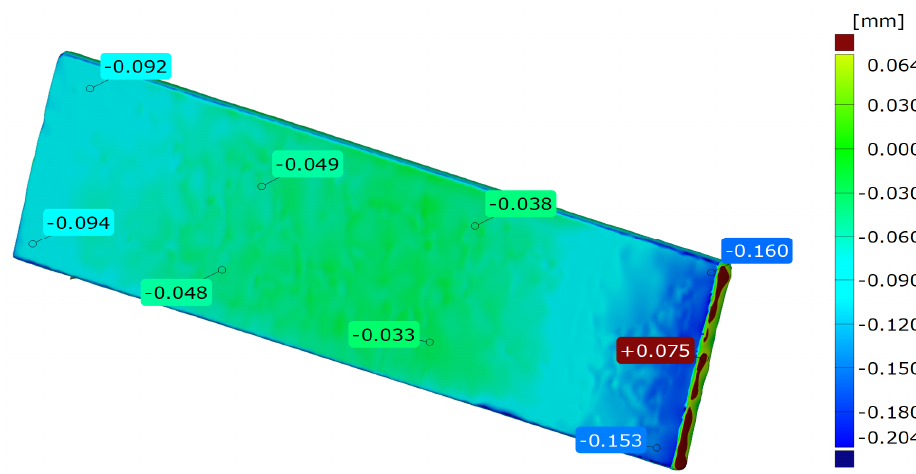
Figure 6. The results of 3D optical scanning tests of samples made of AlSi10Mg–DMLS.